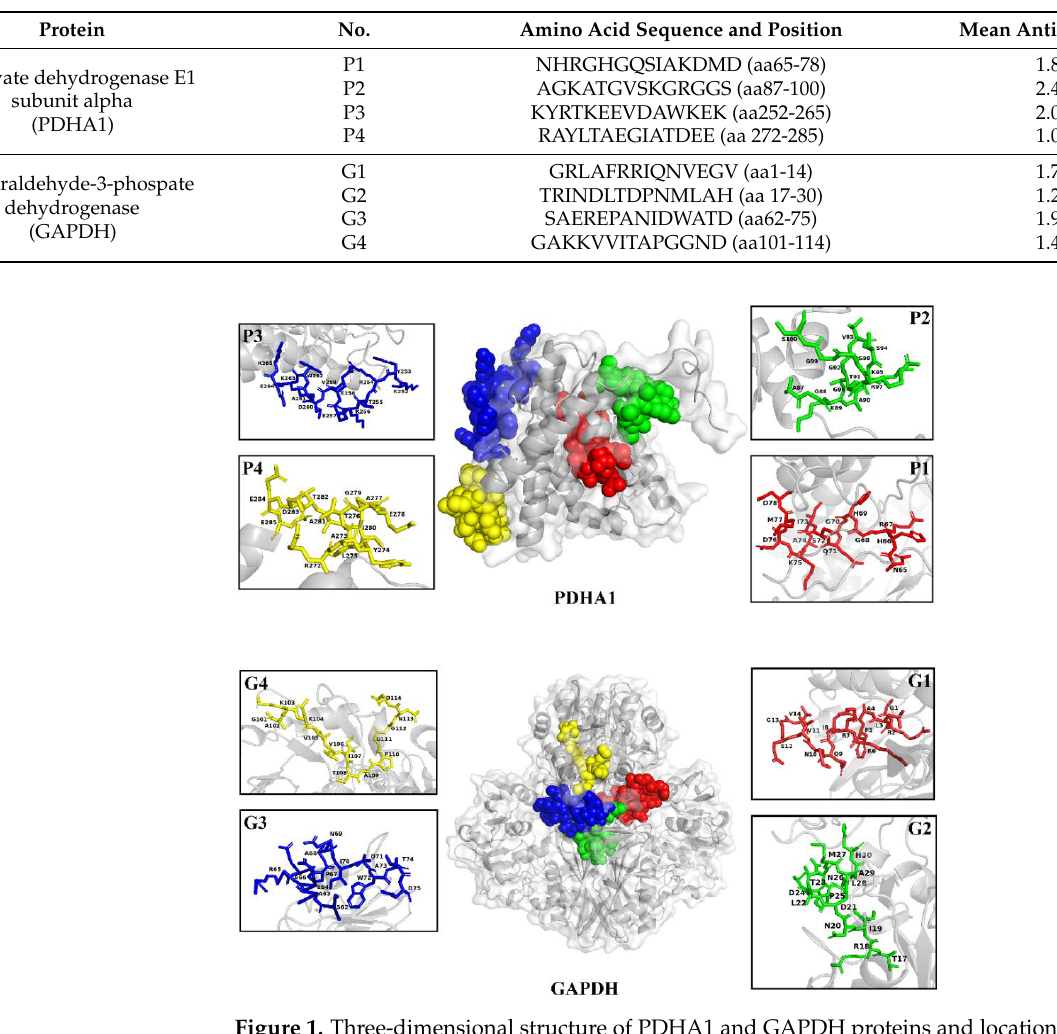
Figure 1. Three-dimensional structure of PDHA1 and GAPDH proteins and location of the predicted epitope